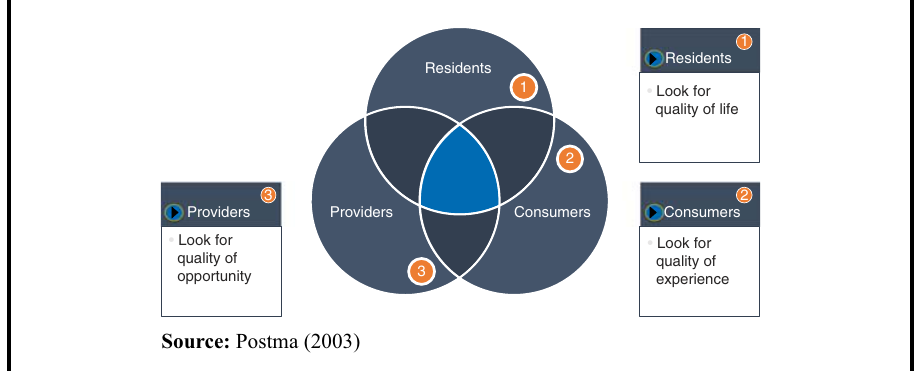
Figure 1 Quality of life: equal demands on tourism